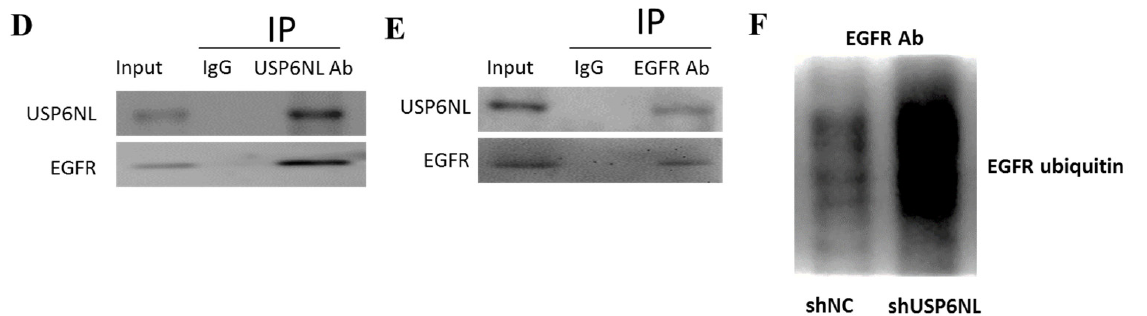
Figure 6. Effect of USP6NL inhibition on the expression of autophagy markers in GBM cells. ( A ) Bioinformatics analysis of the correlation expression of USP6NL and EGFR with autophagic markers ATG5, ATG7, Beclin-1, and LC3A/B. ( B , C ) Immunofluorescence image and Western blot analysis of the expression of autophagic markers after USP6NL inhibition and TMZ treatment. Scale bar: 10 µm ( D – F ) Coimmunoprecipitation to demonstrate the association of USP6NL with EGFR and the regulation of EGFR ubiquitination, with or without USP6NL. * p < 0.05, *** p < 0.001.